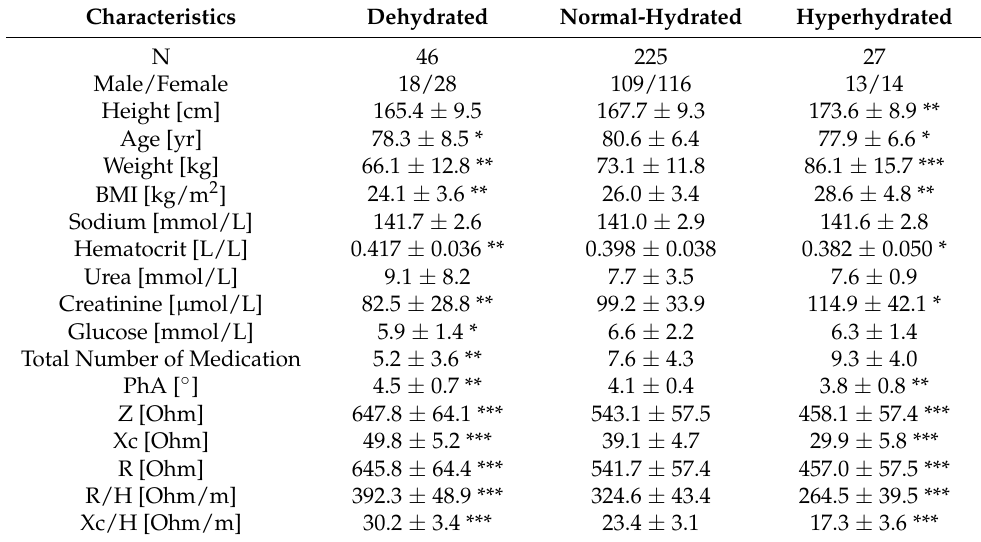
Table 1. Baseline Characteristics and impedance values of the patients classified by hydration status (see also Figure 1), average ± standard deviation, * = p ≤ 0.05, ** = p ≤ 0.005, *** = p ≤ 0.0001. Characteristics Dehydrated Normal-Hydrated Hyperhydrated N 46